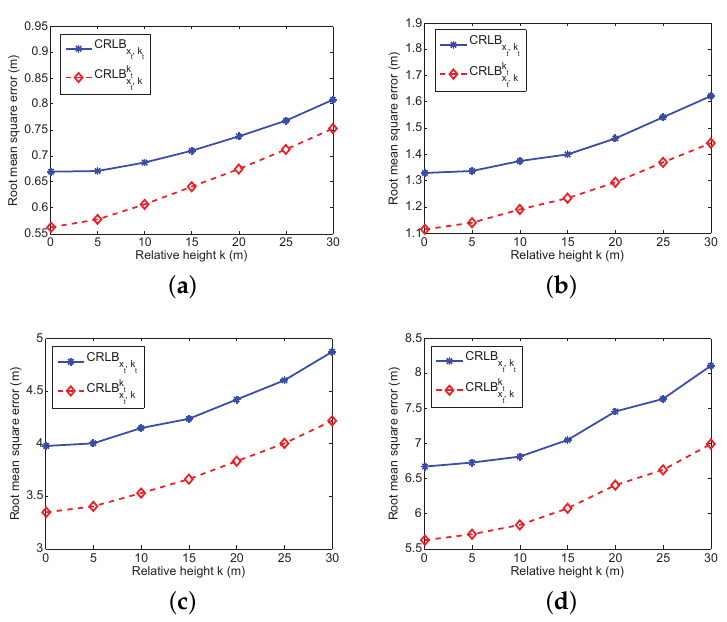
∼ N ( 0,0.5 2 ) ; ( b ) v j t ∼ N ( 0,5 2 ) . t